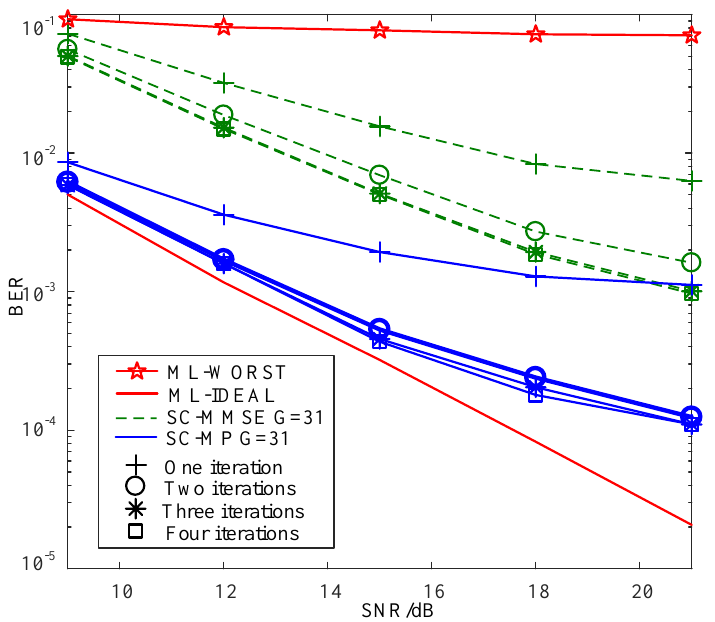
Figure 3. BER comparisons of the proposed SC-MMSE and SC-MP detectors for the GSTFIM systems with N t = 2 and N r = 2.